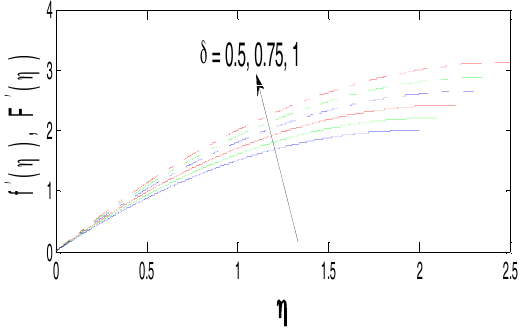
Figure 4. Impact of δ on velocity profile f (cid:48) and F (cid:48) of fluid with dusty particles.